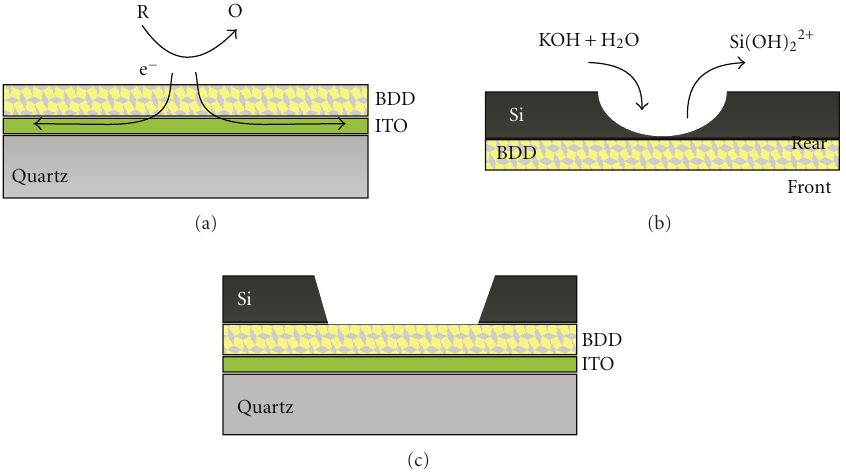
Figure 1: (a) Redox reaction on BDD surface and electron transfer through BDD membrane and along ITO film. (b) Chemical etching of silicon support to prepare free-standing BDD membrane. (c) Hybrid structure of diamond membrane—ITO